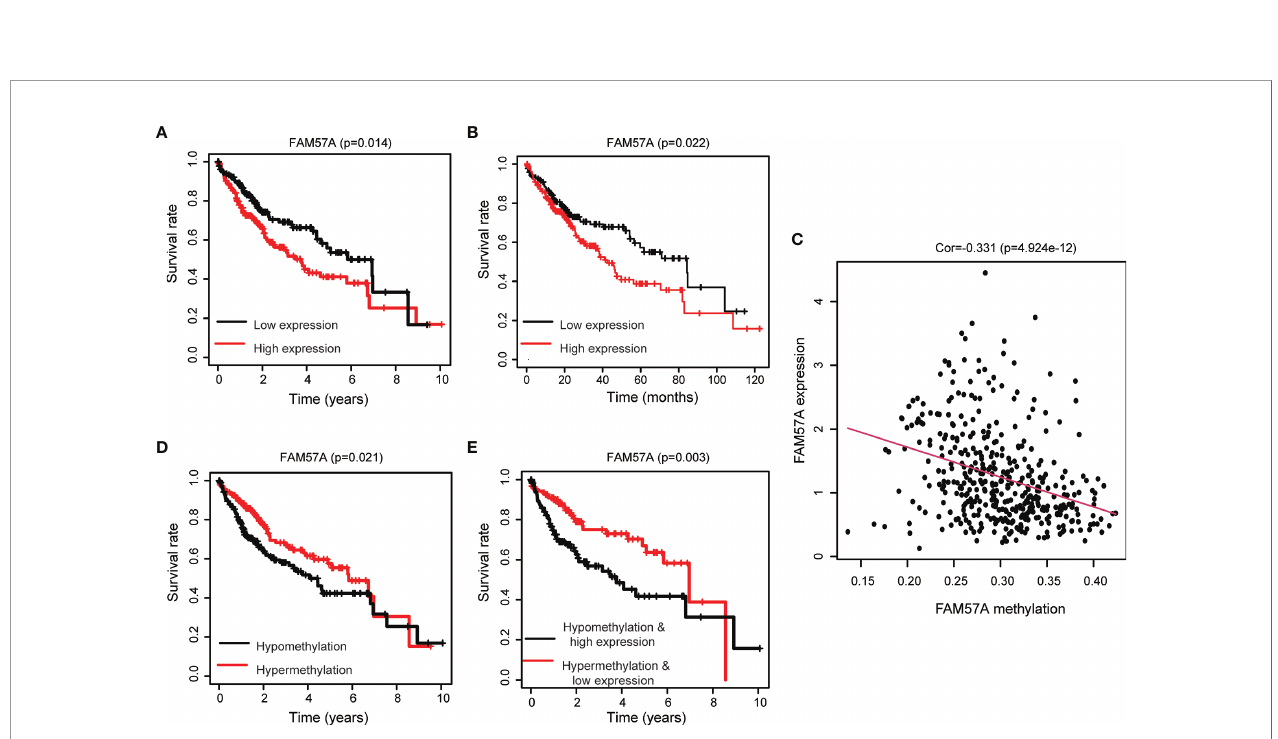
FIGURE 3 | Impact of the FAM57A level and methylation on survival in HCC patients. (A) Correlation of OS with FAM57A expression in TCGA. (B) Correlation of OS with FAM57A expression in the K-M plotter. (C) Negative correlation between FAM57A expression and methylation. (D) Correlation of OS with FAM57A methylation in TCGA. (E) Joint survival analysis of FAM57A methylation and expression in TCGA. OS, overall survival.